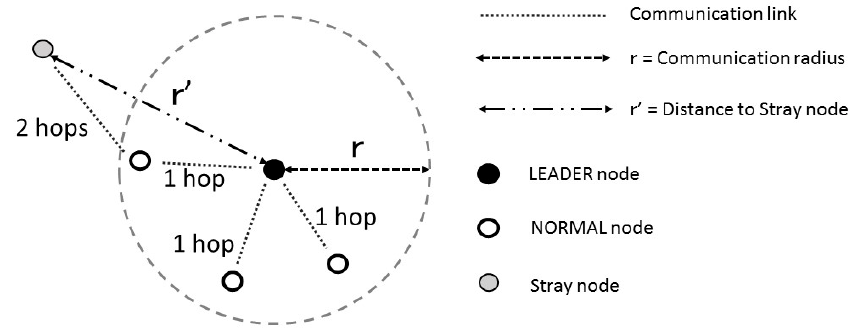
Figure 3. Overview of the stray node detection protocol.